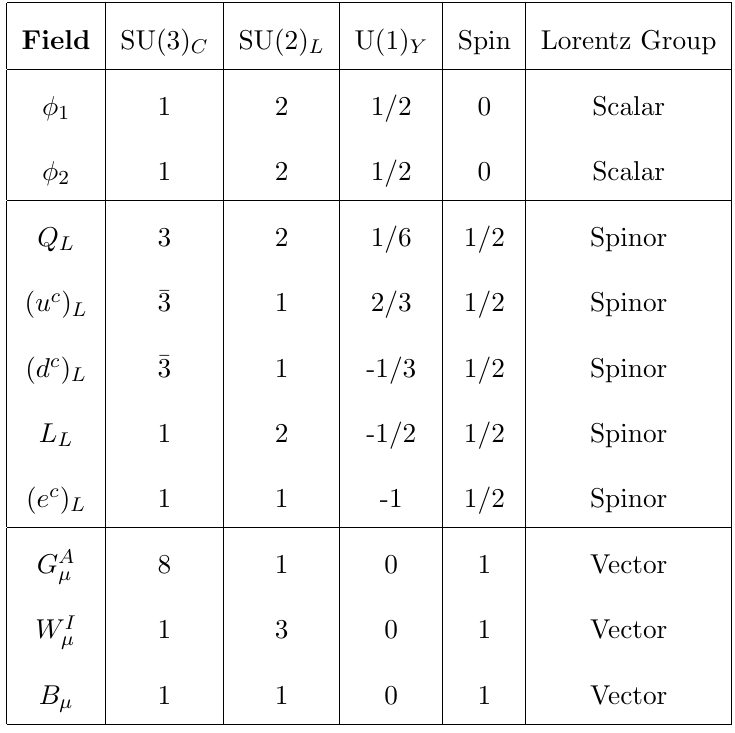
Table 1. 2HDM: quantum numbers of the